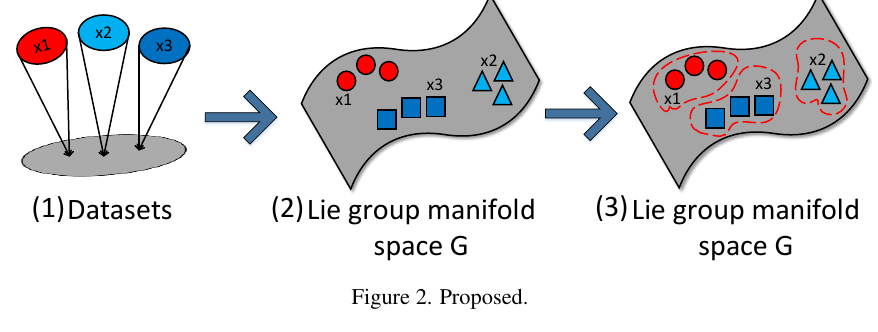
Figure 2. Proposed.